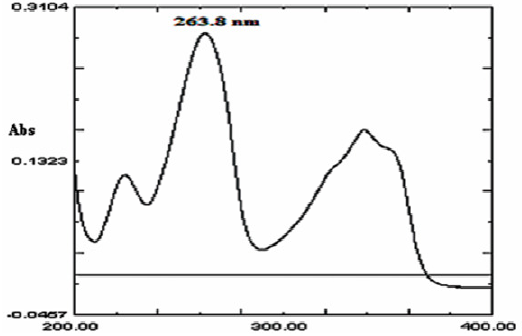
Figure 1. Zero order UV spectrum of gemifloxacin mesylate, 4 µ mL -1